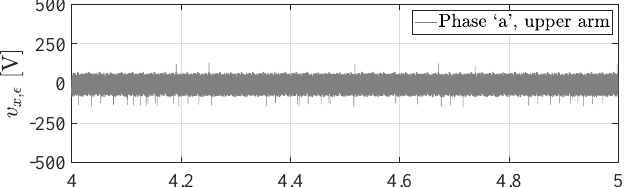
Figure 13. The residual voltage as defined in (6) for the phase “a” upper arm of the MMC with modified ST algorithm.